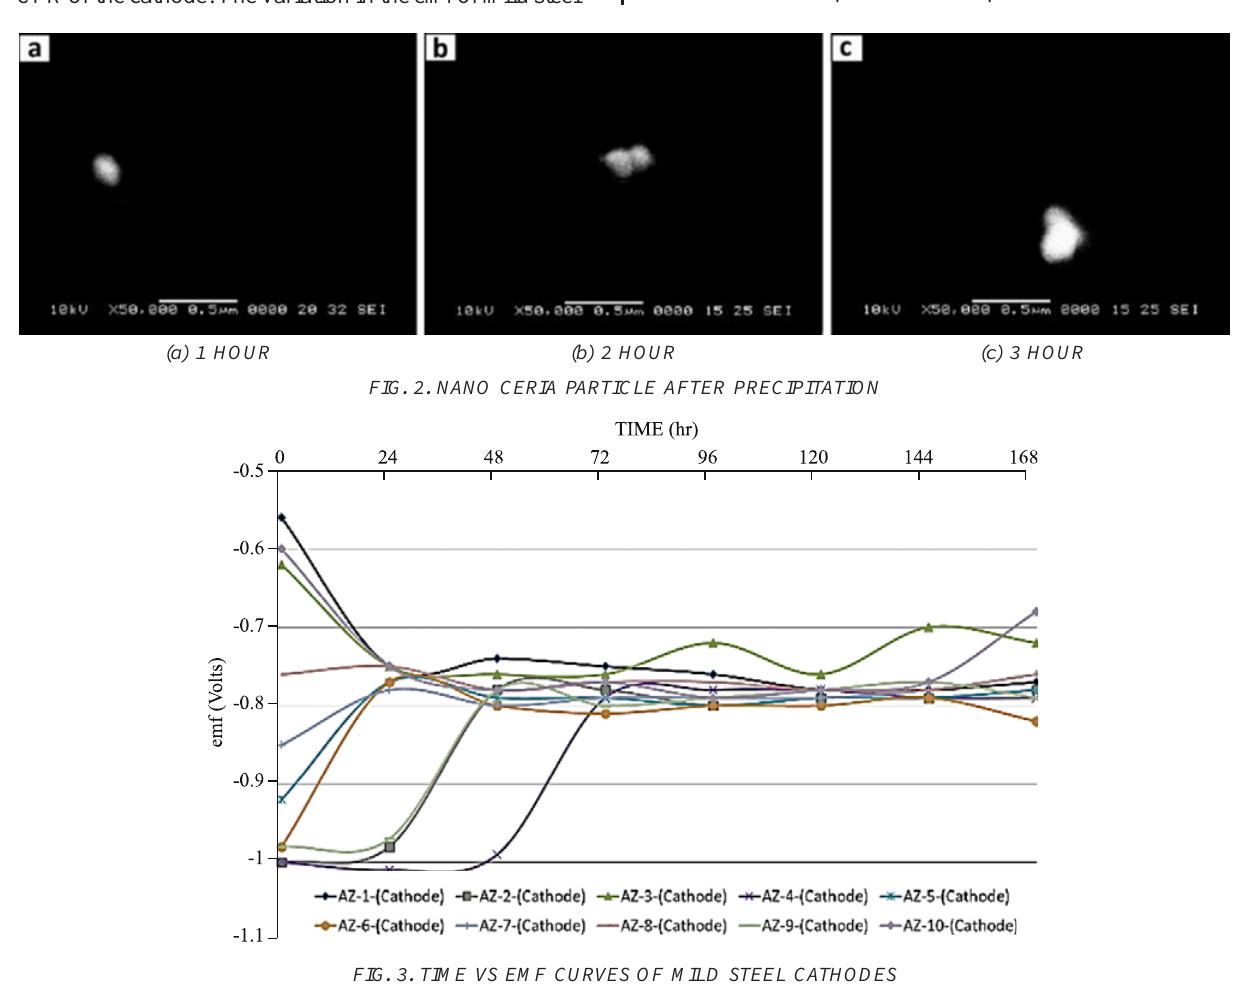
FIG. 3. TIME VS EMF CURVES OF MILD STEEL